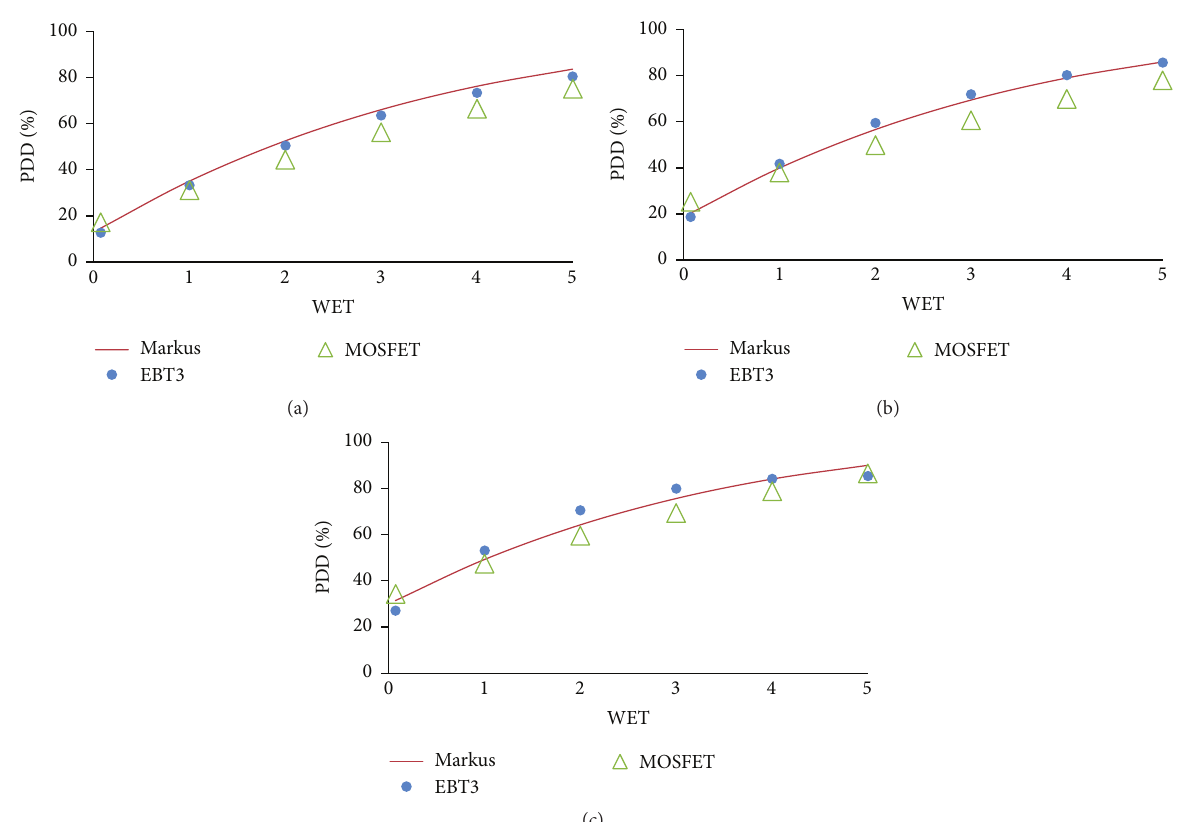
Figure 3: Percentage depth doses (PDDs) for normally incident 6 MV photon beams at open fields with different sizes at 100cm fixed SSD. The doses at 0, 1, 2, 3, 4, and 5mm effective depths for each dosimeter were calculated by interpolation, and the following field sizes were investigated: 5 × 5 cm 2 (a), 10 × 10cm 2 (b), and 20 × 20 cm 2 (c).